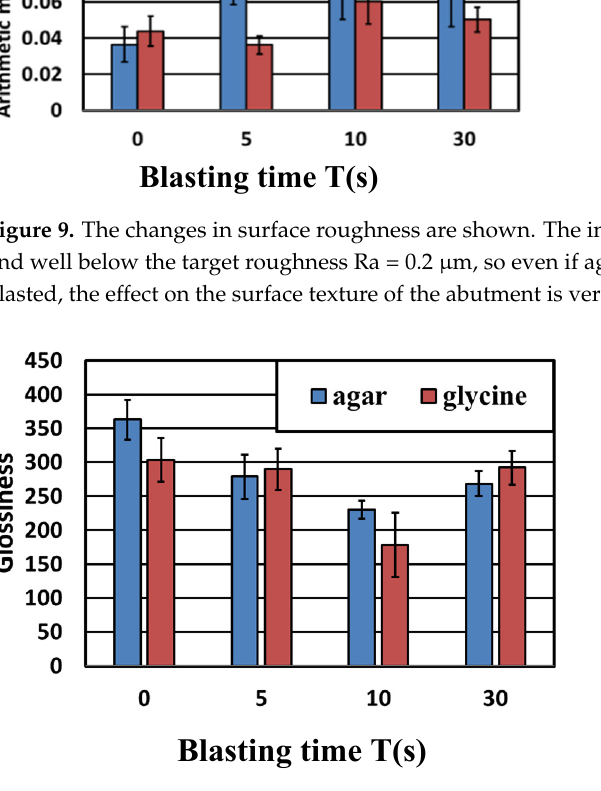
Figure 10. The changes in glossiness are shown. After blasting, glossiness is reduced, but the rate of reduction is low. Gloss remains on the blasted surface, and changes cannot be visually confirmed.